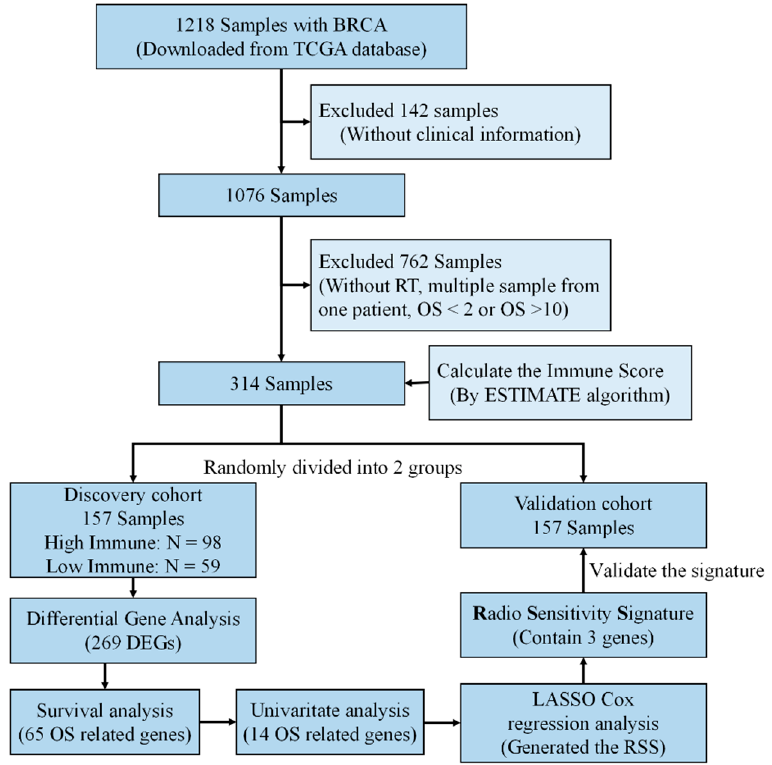
Figure 5. Study designs. A prognostic classifier was constructed in the discovery cohort ( n = 157) and was further certified in the validation cohort ( n = 157).